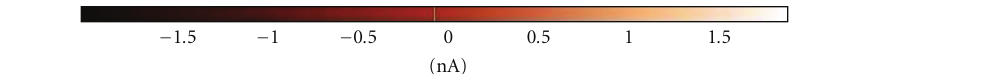
Figure 3: Relief of polymer films with the introduction of 0wt.% (a), 4 wt.% (b), 8wt.% (c), 12 wt.% (d) ZnO nanoparticles (AFM). The size of photos 5 × 5 mkm.